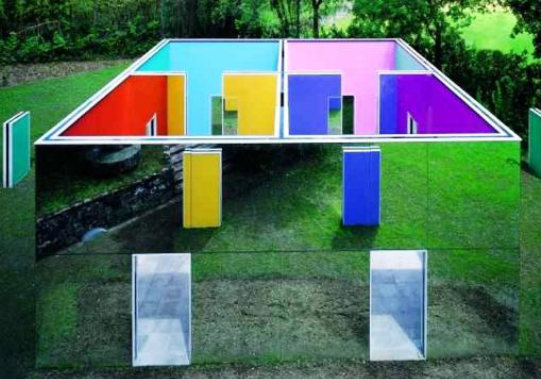
Figure 7. The garden of cosmic speculation (Dumfries, Figure 8. Villa Celle Gardens Pistoia,